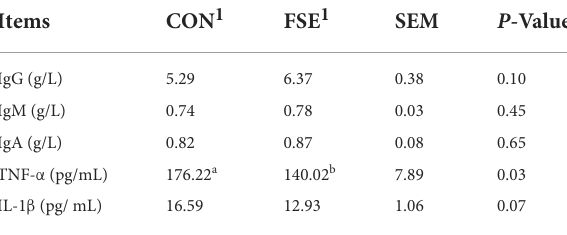
TABLE 7 Effect of Forsythia suspensa extract on serum immunoglobulin and interleukin cytokines in finishing